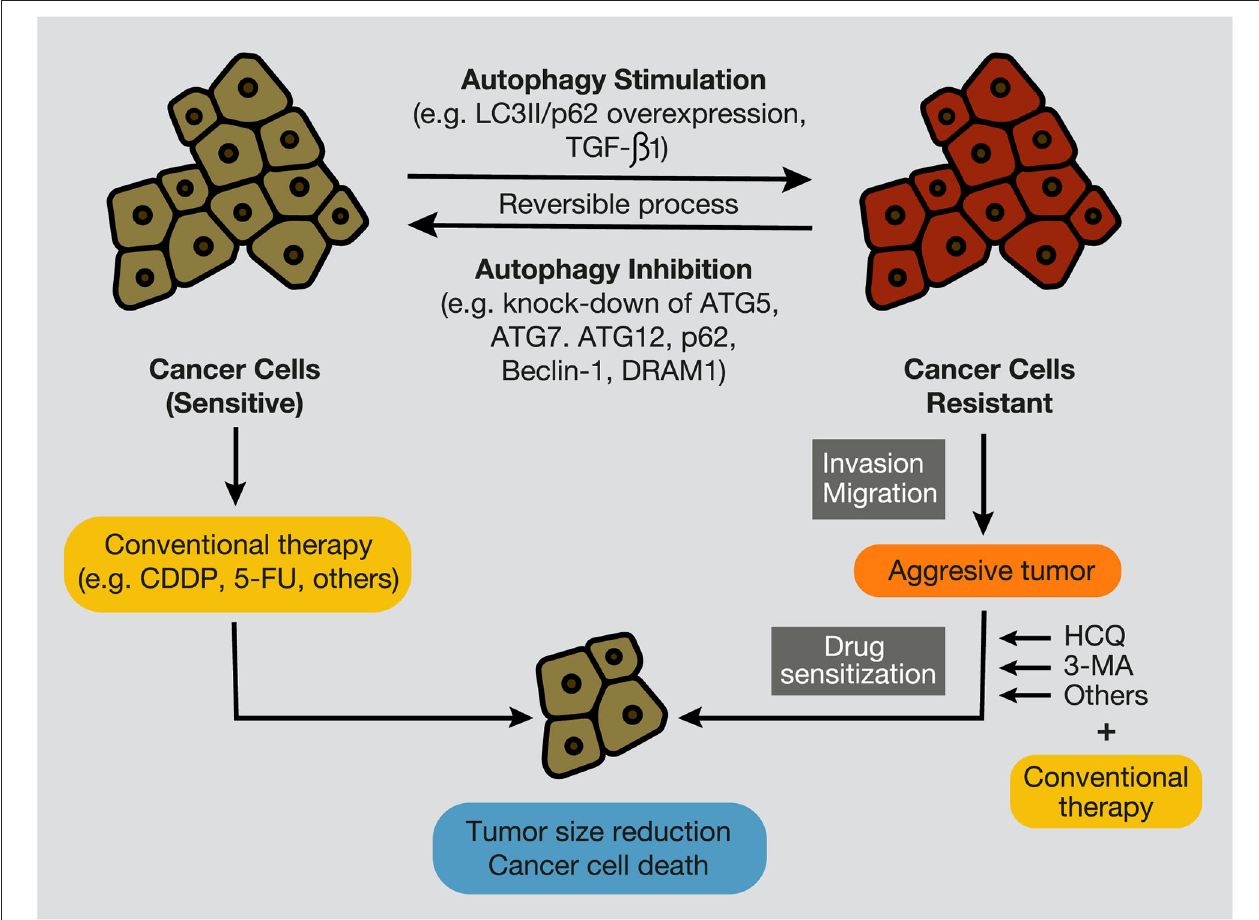
FIGURE 7 | Autophagy stimulation and inhibition in cancer cells. During tumor development, autophagy inhibition, by targeting autophagy-related proteins, such as ATG7, Beclin-1, p62/SQSTM1, and DRAM1, promotes the sensitization of cancer cells to conventional anticancer treatments, such as chemotherapeutic agents, including CDDP and 5-FU. In contrast, autophagy stimulation, evidenced by overexpression of LC3II and p62/SQSTM1, and by high levels of TGF- β 1, provokes cancer cell resistance to therapies (e.g., chemotherapy and radiation), development of an aggressive phenotype, and increment of migratory and invasive capacities. In this case, several autophagy inhibitors, such as CQ, HCQ, or 3-MA, can re-sensitize resistant tumors and promote tumor regression and cancer cell death. CQ, chloroquine; HCQ, hydroxychloroquine; 3-MA, 3-methyladenine; CDDP, cisplatin; 5-FU, 5- fluorouracil.